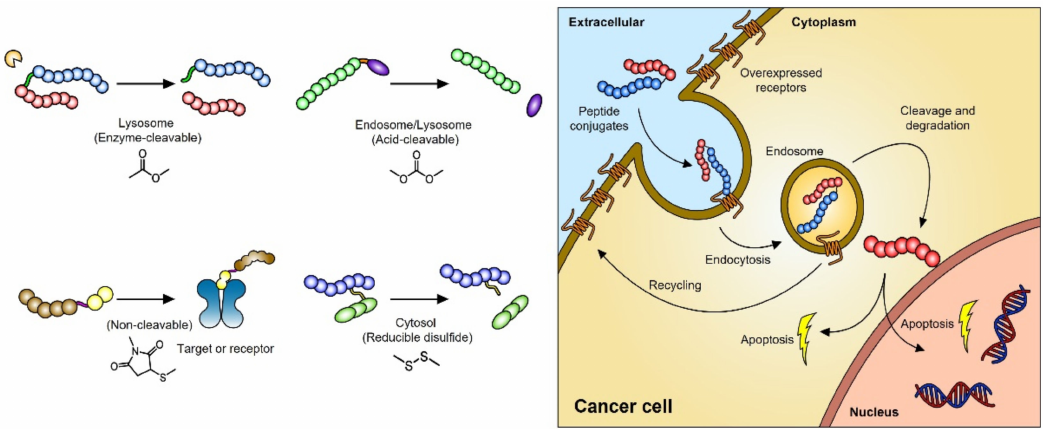
Figure 2. Due to the excellent function of peptides, they are often combined with a cytotoxic drug via a chemical linker in anticancer therapy. A number of functional and selective linkers can be used differently to design new therapeutics. These bioconjugates are usually taken up into cells by endocytosis and then cleaved by enzymes or other substances to release the cytotoxic